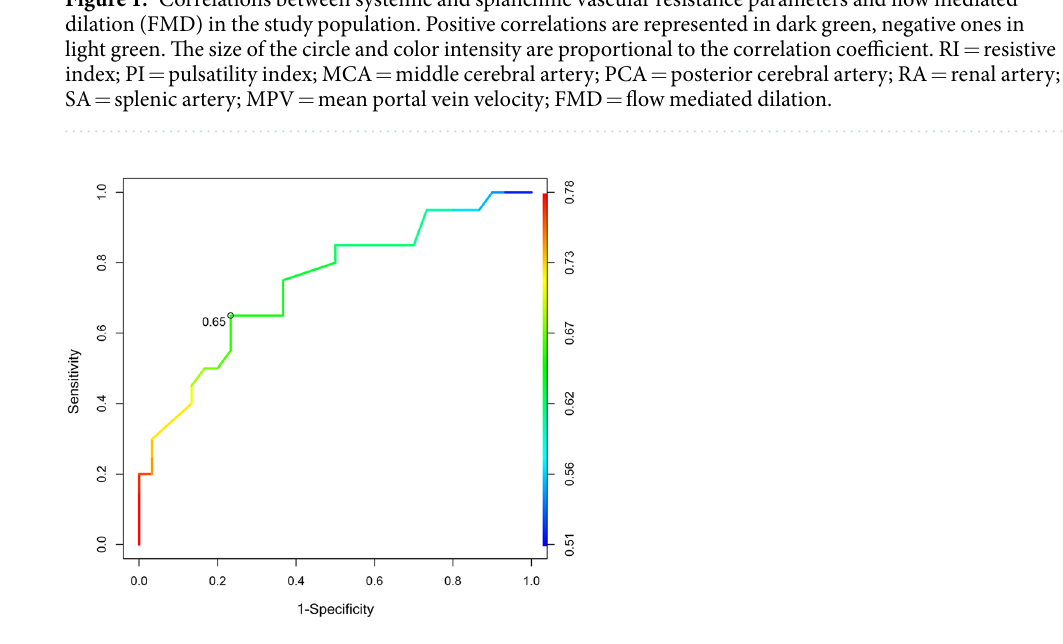
Figure 2. Receiver operating characteristic (ROC) curve of middle cerebral artery resistive index (MCA-RI) for discriminating the presence or the absence of minimal hepatic encephalopathy (MHE). The cut-off value of 0.65 resulted in the best accuracy (74%), with 65% sensitivity and 76%